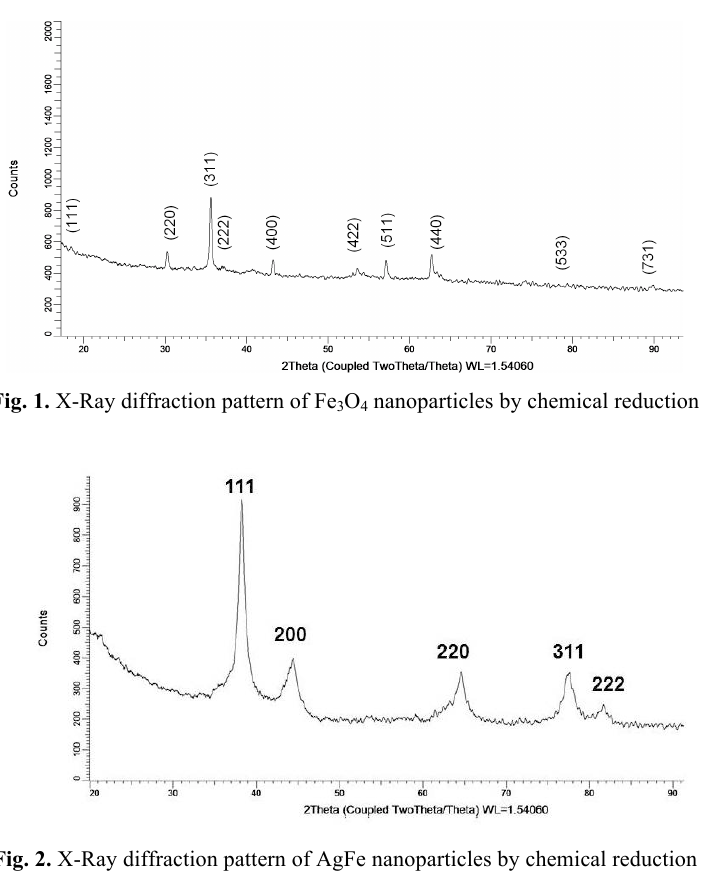
O and AgFe nanoparticles synthesized by chemical 3 4